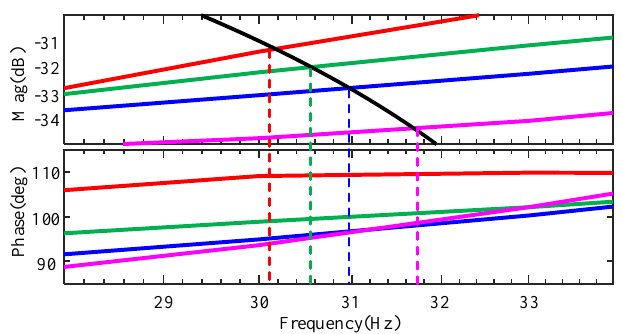
Figure 15. Zoom Bode diagram of different damping of reactive power.